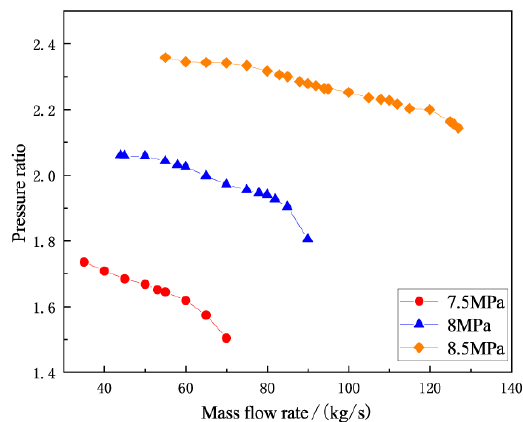
Figure 9. Pressure ratio versus mass flow rate at various inlet